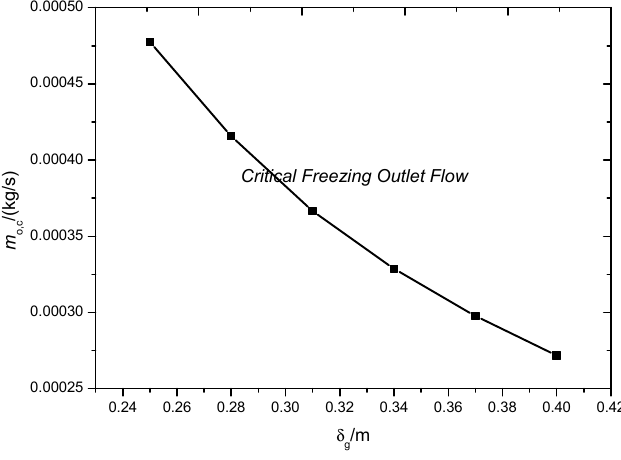
Figure 13. Critical freezing outlet flow versus fin thickness.